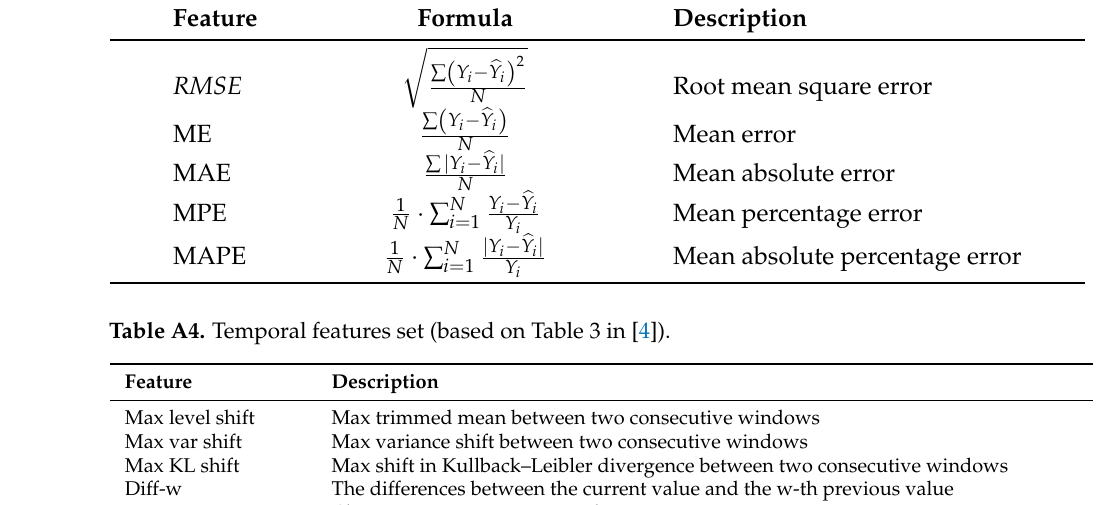
Table A3. Forecasting error features (based on Table 2 in [4]).